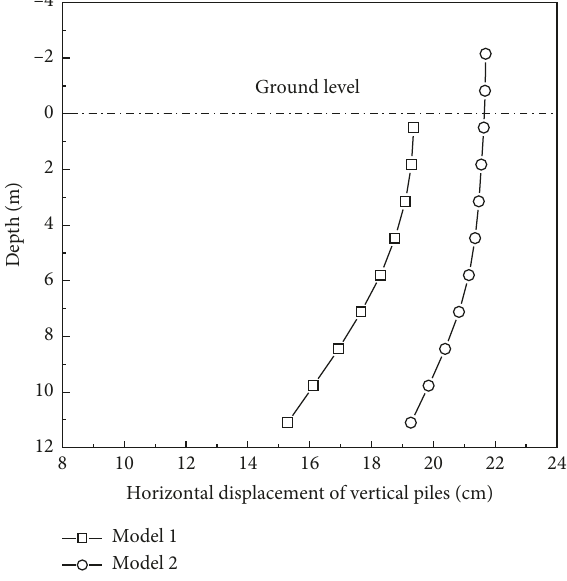
Figure 22: Contrastive analysis of horizontal displacement of vertical